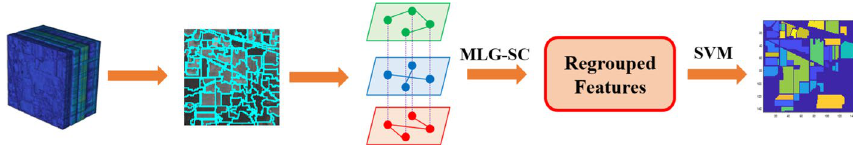
Fig. 4 Scheme of single-resolution